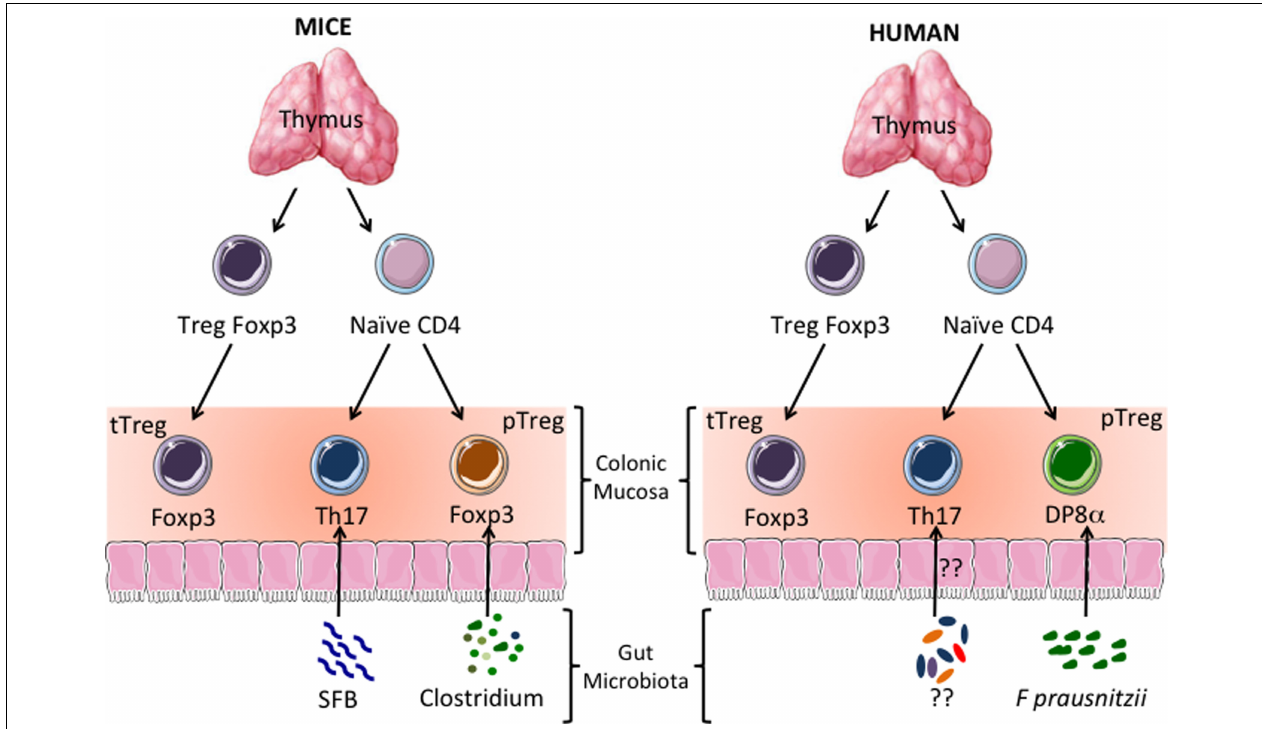
FIGURE 1 | Human CD4CD8 αααααα (DP8 ααα ) regulatory T cells (Treg): functional homologs of the Tregs induced by clostridial bacteria in mice? In mice and humans, a subpopulation of CD4 +++ thymocytes develops into Tregs expressing the transcription factor Foxp3. These thymus-derived Tregs (tTregs) migrate to all tissues, including the colonic mucosa, where they prevent autoimmune reactions. Thymus-derived naïve CD4 + T cells also migrate to the colonic mucosa. There, depending on the type of antigen-dependent signals they receive, they develop into effector lymphocytes or peripherally induced Tregs (pTregs). It has been shown in mice that colonic Th17 and Foxp3 + IL-10-secreting pTregs are induced by segmented filamentous bacteria (SFB) and clostridial bacteria, respectively. In the human colonic mucosa, IL-10-secreting DP8 α Tregs induced by Faecalibacterium prausnitzii ( F. prausnitzii ), a gut bacterium belonging to the Clostridium cluster IV, seem to be the homologs of the mouse Foxp3